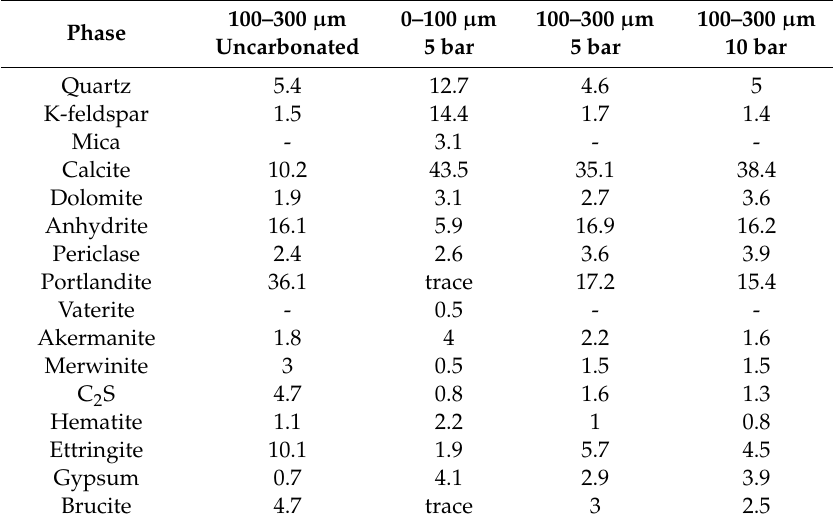
Table 10. Phase composition of